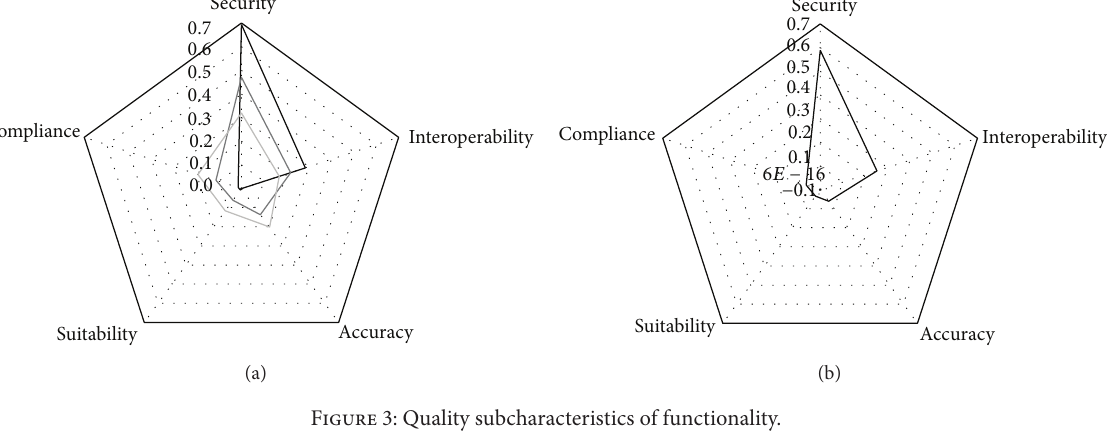
Figure 3: Quality subcharacteristics of functionality.